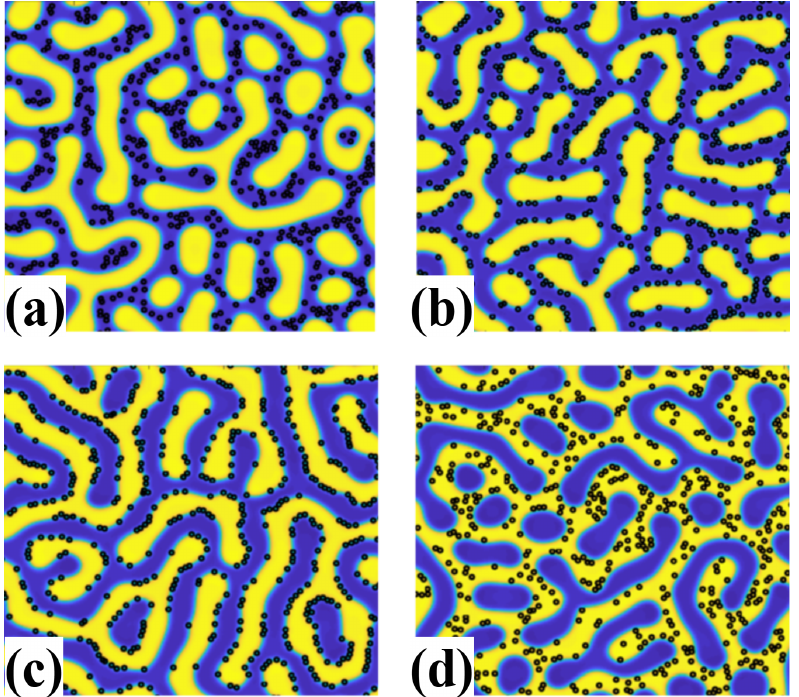
Figure 3. Role of affinity parameter ψ 0 controlling the dispersion of a low concentration φ p = 0.06 of NP within a lamellar-forming BCP melt. NPs (shown in black) are segregated within the blue phase in ( a ) for ψ 0 = − 1, slightly off-center within the interface in ( b ) for ψ 0 = − 0.33, symmetrically at the interface in ( c ) for ψ 0 = 0 and within the yellow phase in ( d ) for ψ 0 = 0.67. Reprinted with permissions from Ref. [57]. Copyright 2018 Wiley